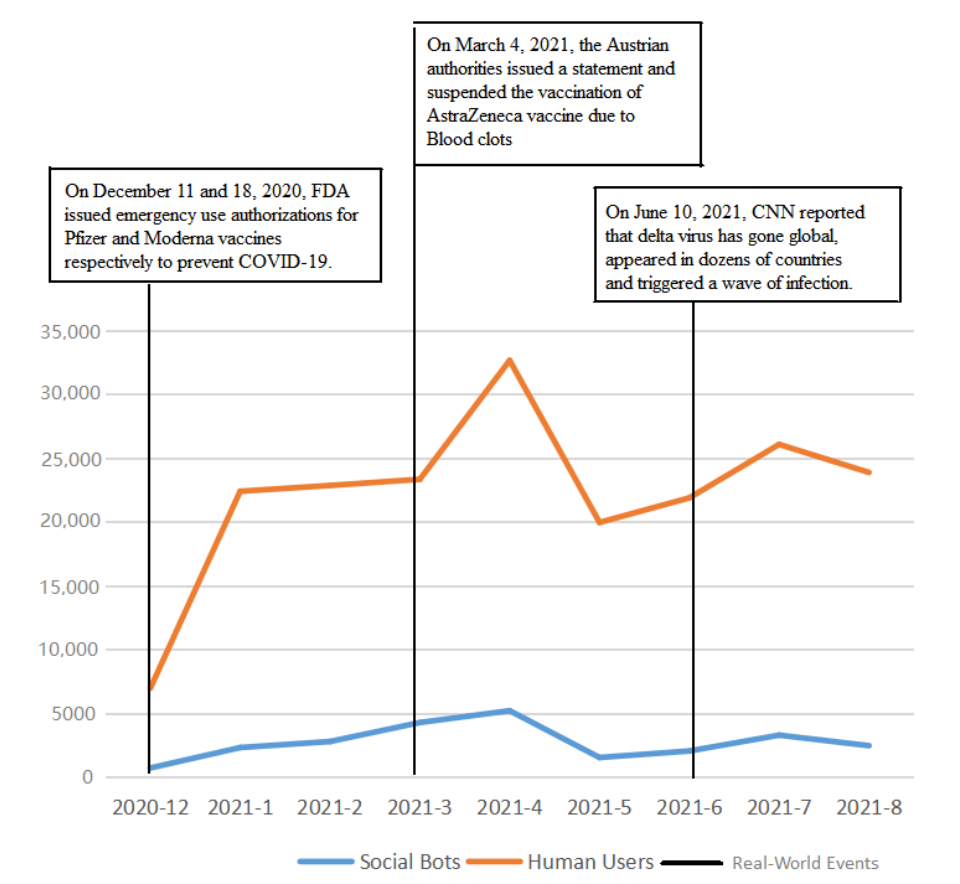
Figure 3. Trends of Tweets Published by Social Bots and Human Users Related to Real-World